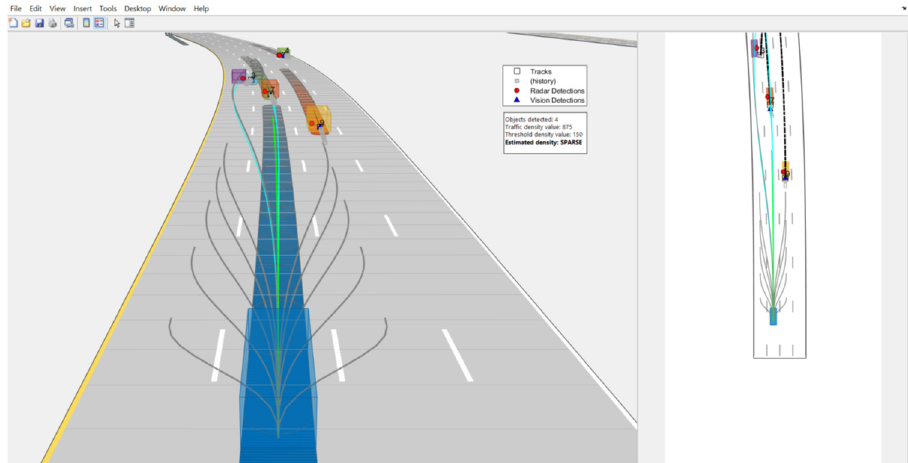
Figure 16. Simulation of the highway scenario in MATLAB to calculate the efficacy of the RTDE.